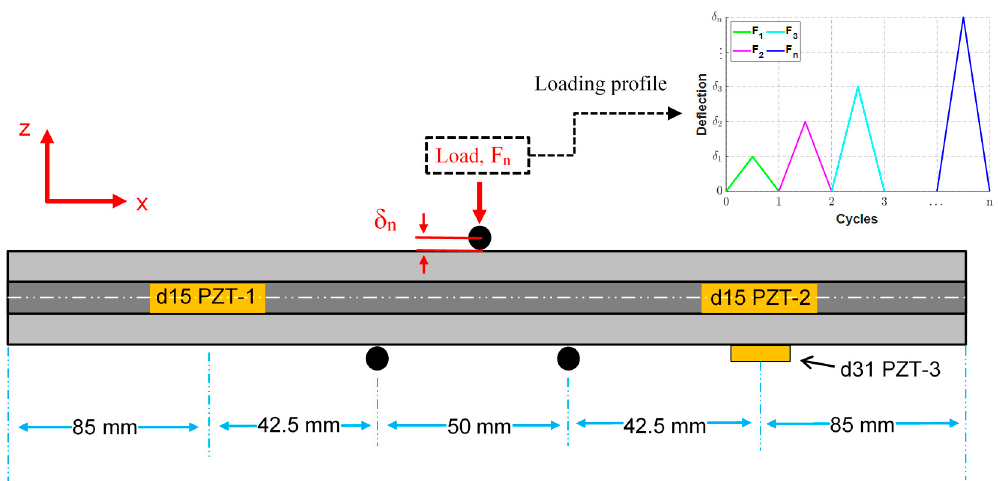
Figure 4. Laminate specimen under a quasi-static three-point bending force applied cyclically at mid-span.